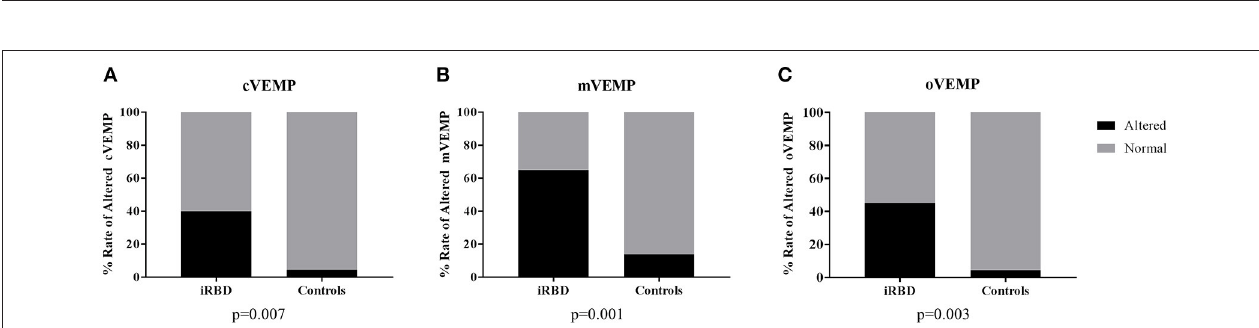
FIGURE 2 | Rates of alterations of each VEMPs in patients and controls. (A) cVEMP, cervical VEMP; (B) mVEMP, masseter VEMP; (C) oVEMP, ocular VEMP; iRBD, idiopathic REM Behavior Disorder. Statistics: χ 2 test.